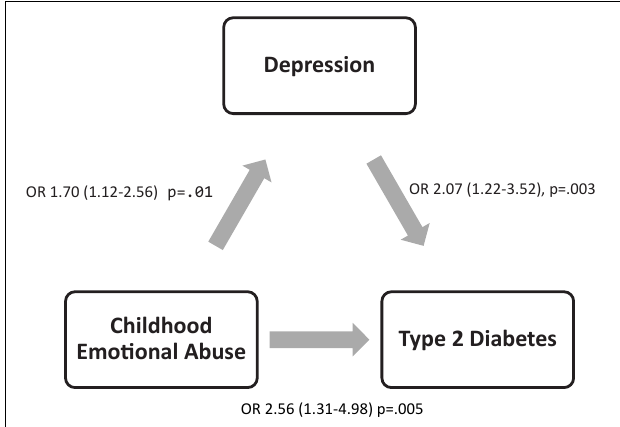
FIGURE 2 | Mediation analysis of childhood emotional abuse, depression, and type 2 diabetes. Sobel test was used to test the significance of the effect of depression on the association between childhood emotional abuse and type 2 diabetes in fully adjusted regression analyses. Beta estimates with std error and p -values are